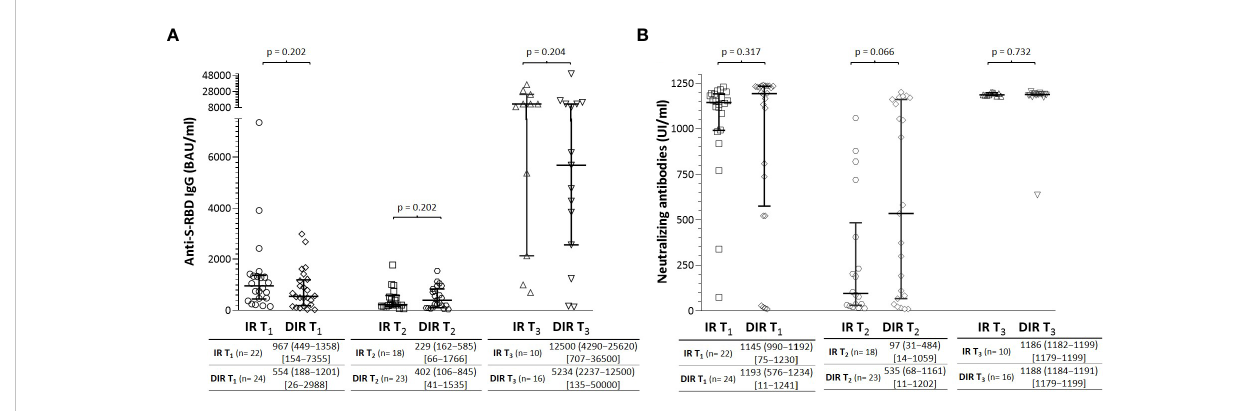
FIGURE 1 (A) Anti-S-RBD IgG and (B) neutralizing antibody titers one month (T1) and 5.5 months (T 2 ) after two mRNA vaccine doses and one month after a third dose (T3) according to the group of participants (IR, immune responders. DIR, discordant immune responders).